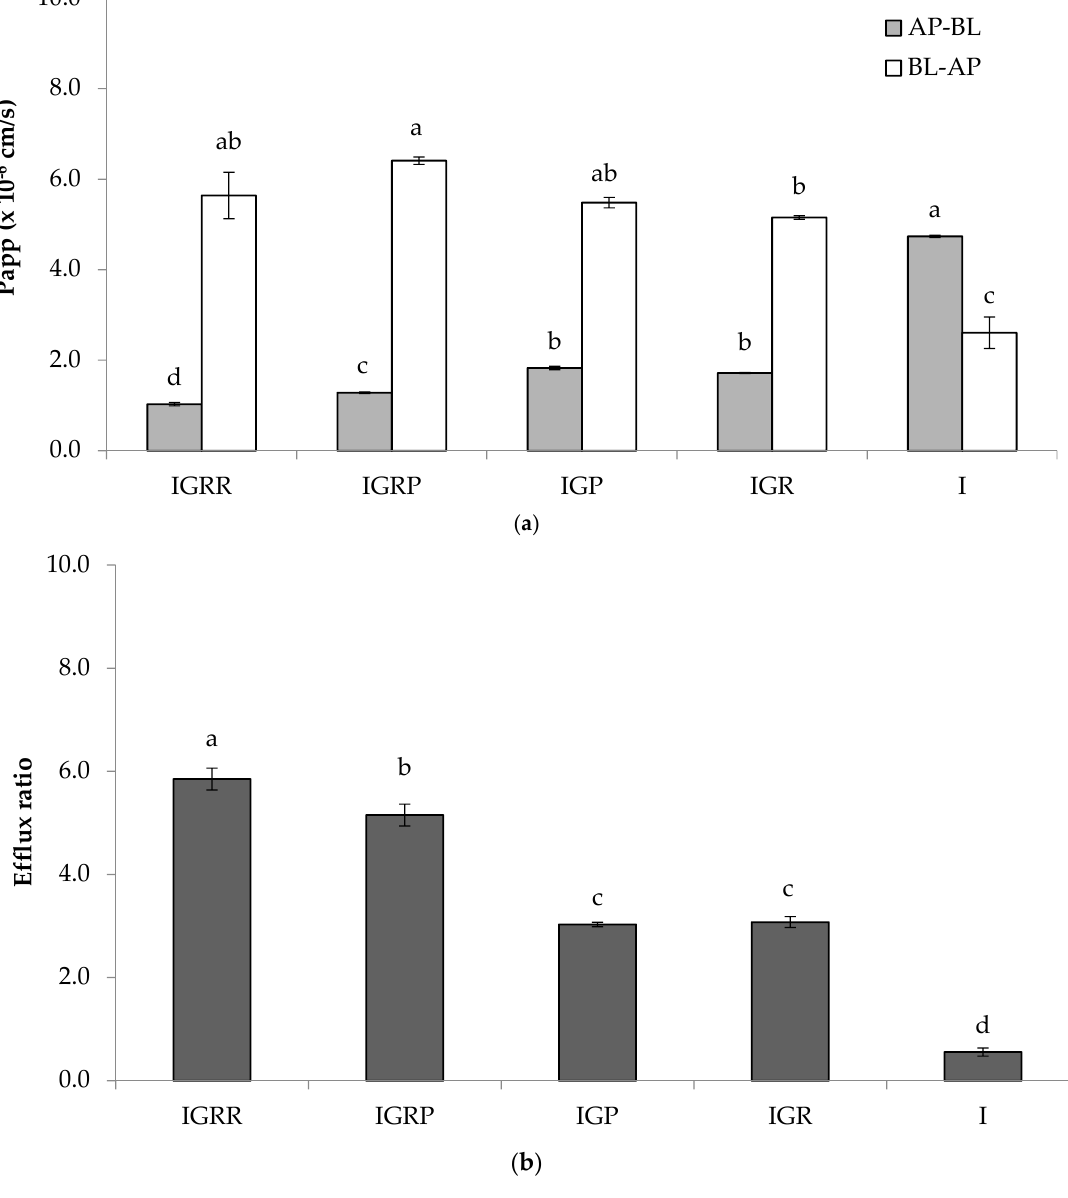
Figure 2. Comparison between permeability of isorhamnetin glycosides from O. ficus-indica extract and isorhamnetin standard in a Caco-2/HT-29 cell monolayer. ( a ) Apparent permeability (Papp) of isorhamnetin glycosides (IGRR, IGRP, IGP, IGR) and isorhamnetin standard from apical to basolateral (AP-BL), and basolateral to apical compartment (BL-AP); ( b ) efflux ratio of isorhamnetin glycosides (IGRR, IGRP, IGP, IGR) and isorhamnetin standard. Data was expressed as mean ± standard deviation. IGRR: isorhamnetin-3- O -glucosyl-rhamnosyl-rhamnoside; IGRP: isorhamnetin-3- O -glucosyl-rhamnosyl-pentoside; IGP: isorhamnetin-3- O -glucosyl-pentoside; IGR: isorhamnetin-3- O -glucosyl-rhamnoside; I: isorhamnetin. Different letters indicate significant differences among different isorhamnetin glycosides. Efflux ratio was calculated by the relation between Papp (BL-AP) /Papp (AP-BL) The Papp (AP-BL) value of isorhamnetin [I] aglycone was 2.6–4.6-fold higher than the Papp (AP-BL) value of isorhamnetin glycosides (Figure 2a) due to their difference in hydrophilicity that hinders their entry through the cell membrane. On the other hand, isorhamnetin diglycosides showed